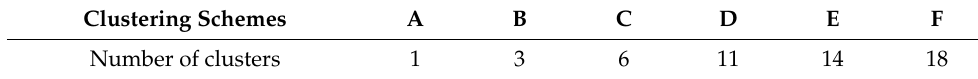
Figure 6. Building groups under different clustering schemes.